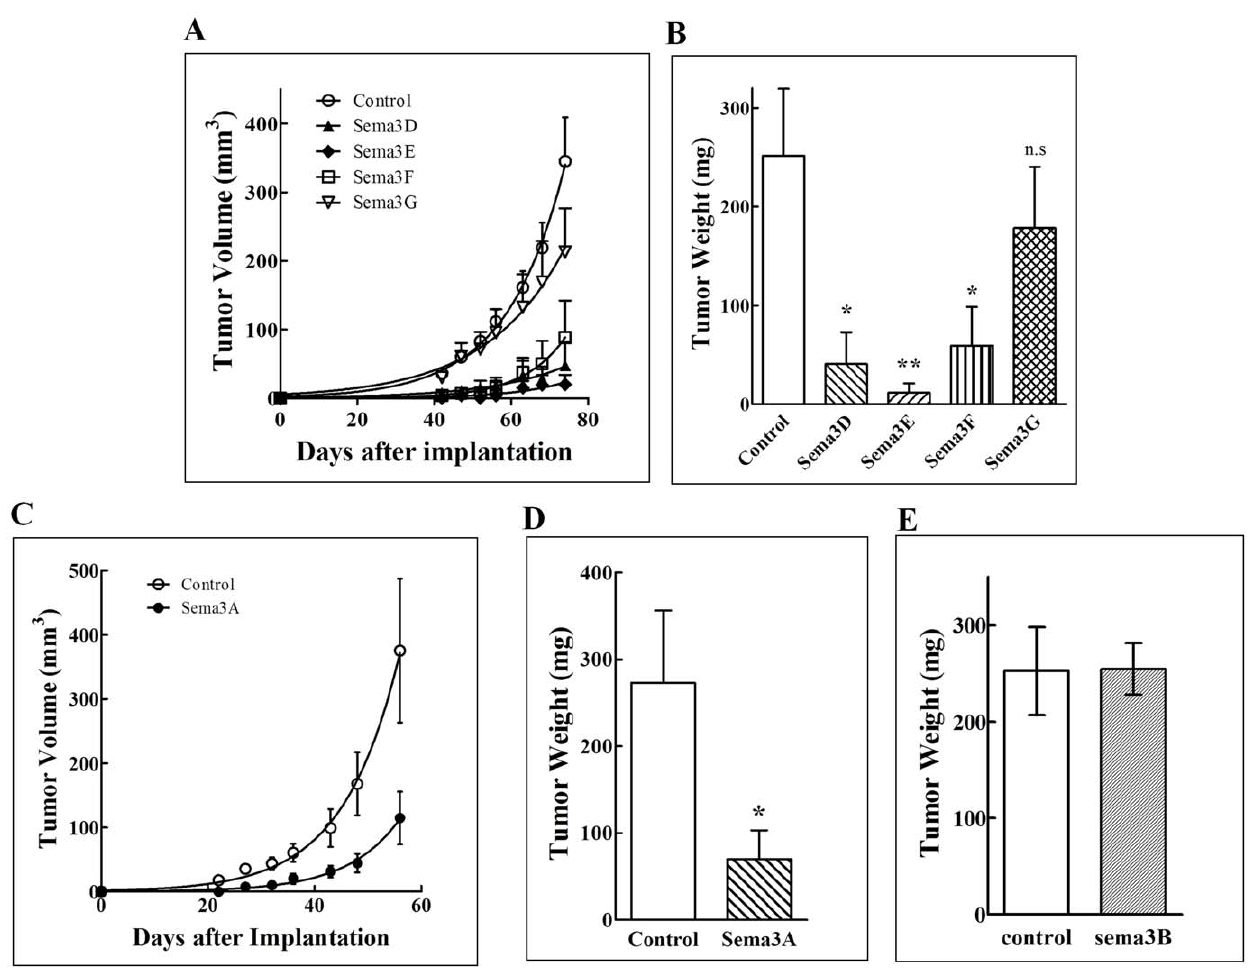
Figure 2. The effect of class-3 semaphorins on the development of subcutaneous tumors derived from u87 mg glioblastoma cells: U87MG cells infected with control lentivirus (control) or infected with lentiviruses directing expression of the designated semaphorins (Sema3X) were implanted subcutaneously in balb\c nu/nu mice as described. (A, C) The average volume of the developing tumors was measured as described. (B, D, E) The average weight of the tumors was determined at the end of the experiment as